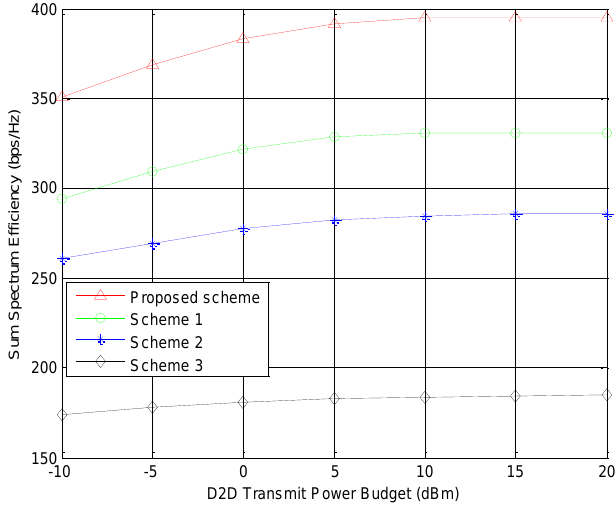
Figure 4. The sum spectrum efficiency versus the transmit power budget.